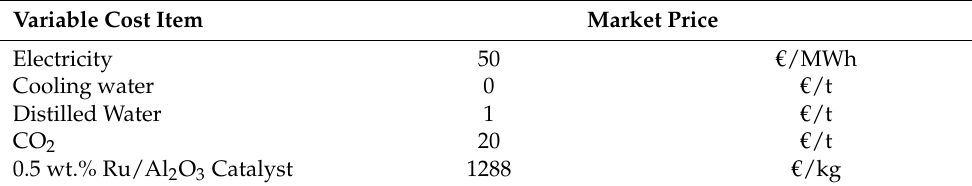
Table 4. Reference case market price for variable costs